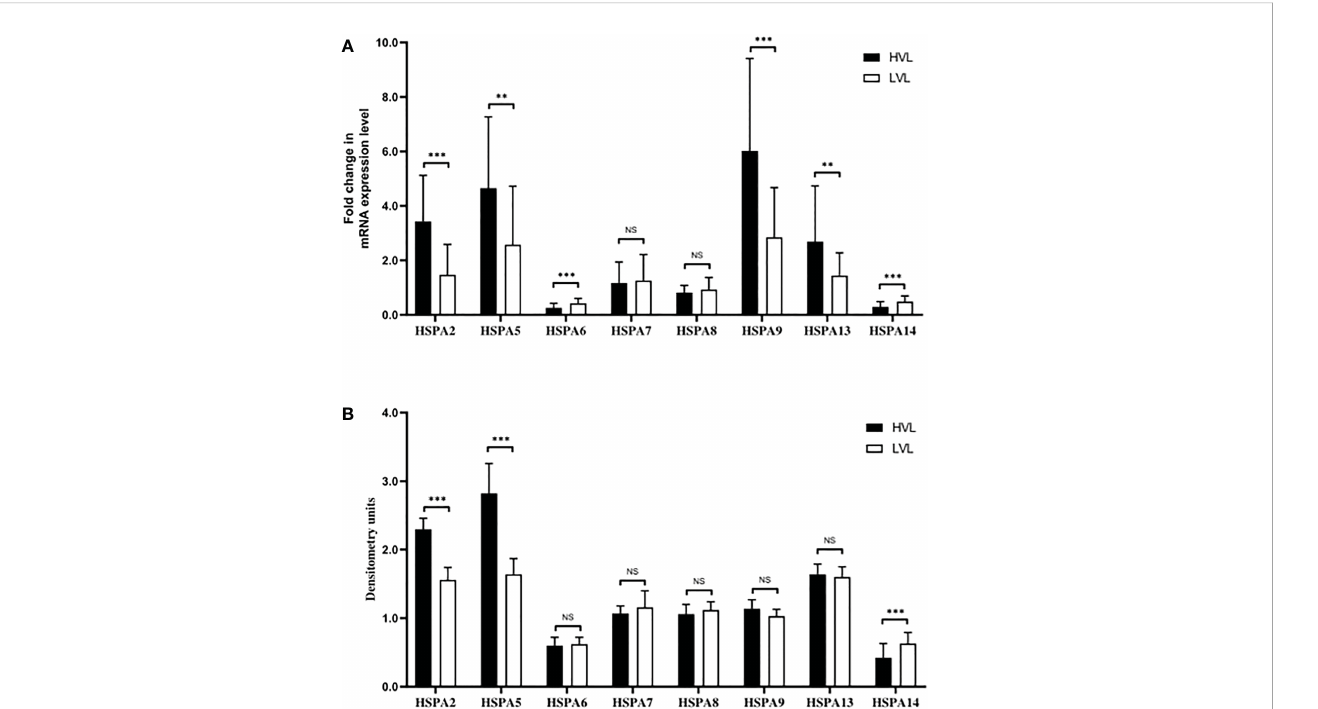
FIGURE 4 Different expression levels of HSPAs in HVL and LVL patients. CD4+ T cells from PBMC of 70 patients were isolated and harvested for RNA and protein lysate preparation. (A) Analyzing and comparing the different HSPA isoforms (including HSPA2, HSPA5, HSPA6, HSPA7, HSPA8, HSPA9, HSPA13 and HSPA14) transcription levels between the LVL and HVL patients by qRT-PCR. (B) Comparing the different HSPA isoforms protein levels between the LVL and HVL patients by western blot and densitometry analysis. Signi fi cance is de fi ned as NS: P>0.05, *P ≤ 0.05, **P ≤ 0.01 and ***P ≤